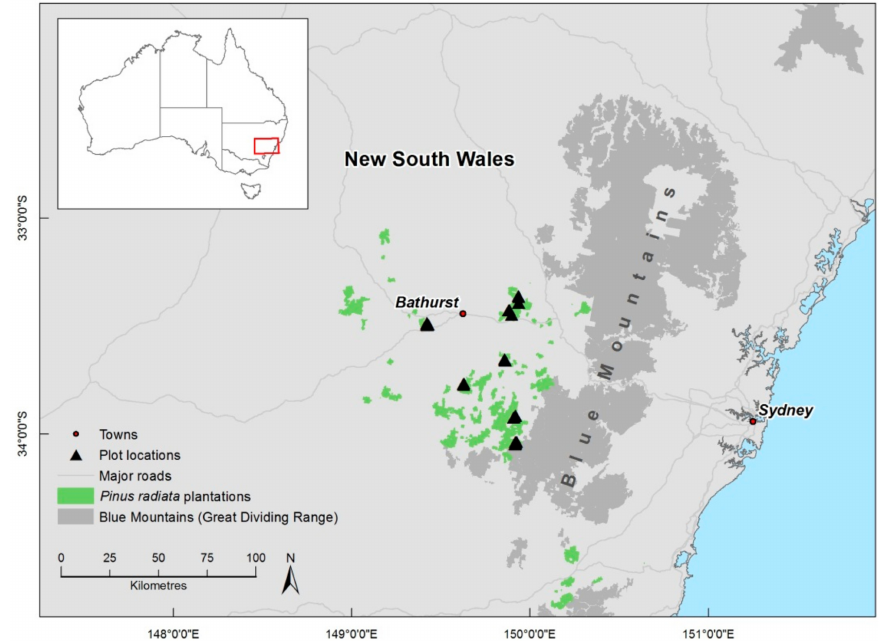
Figure 1. Locations of sampling sites and field plots in the Bathurst management area of the Northern Softwood Region, the Forestry Corporation of NSW on the central west slopes of NSW in Australia (small scale map positioned in the top left-hand corner).